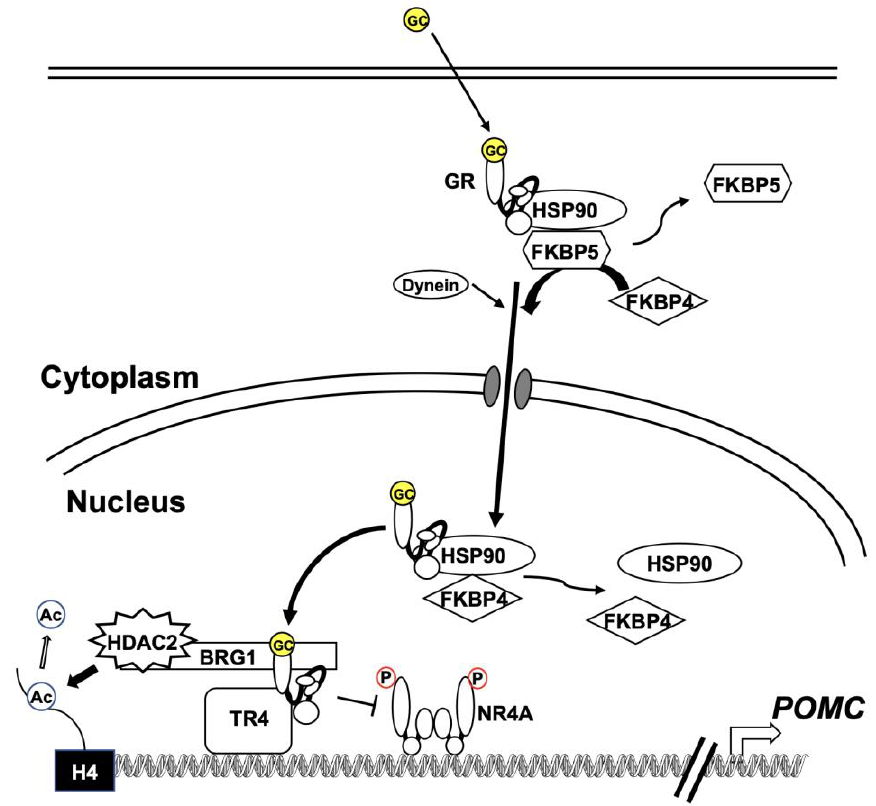
Figure 2. Putative mechanism of glucocorticoid resistance in Cushing’s disease. Corticotroph tumors overexpress heat shock protein 90 (HSP90), leading to disruption of the complex. Strong expression of testicular receptor 4 (TR4) interacts directly with glucocorticoid receptor (GR), which leads to the disruption of GR binding to the proopiomelanocortin (POMC) promoter. GR recruitment requires BRG1, the ATPase component of the SWI/SNF chromatin remodeling complex. Histone deacetylase 2 (HDAC2) results in decreased histone acetylation, which activates POMC transcription. The loss of nuclear expression of either of these proteins, BGR1 or HDAC2, is observed in more than 50% of human corticotroph tumors.